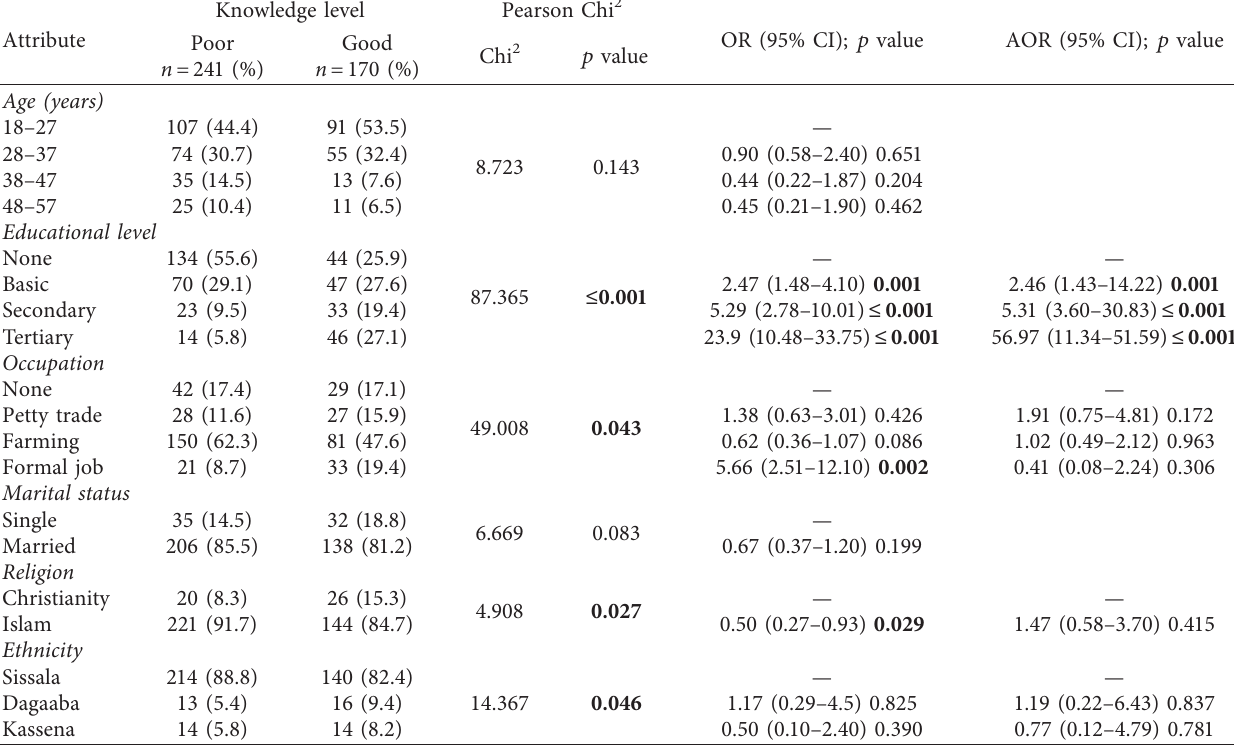
Table 2: Factors influencing households’ knowledge on iodized salt.